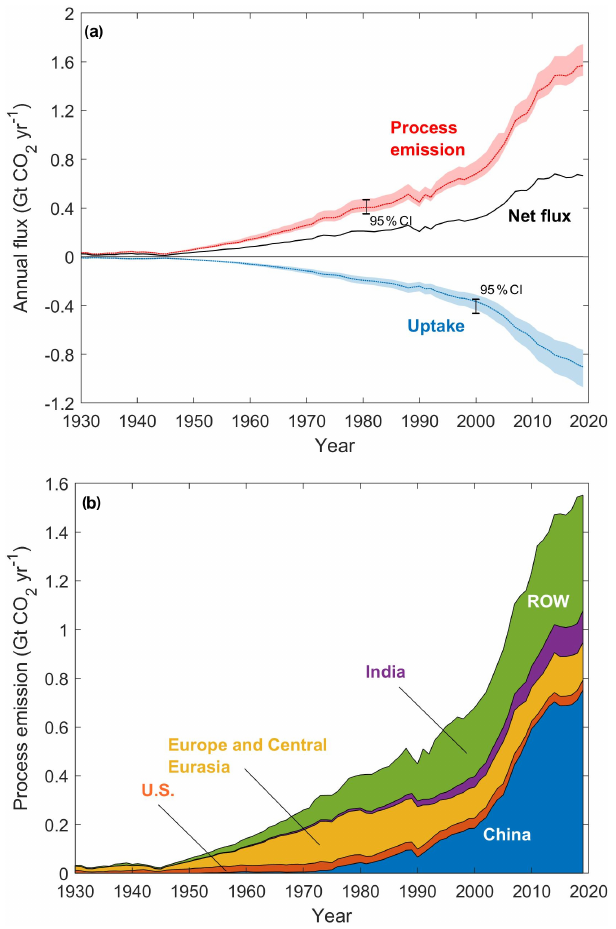
Figure 5. Annual global uptake (median) by cement materials by (a) country or region and (b) type from 1930 to 2019. The uptake is projected onto the y axis as negative values, denoting absorption as opposed to